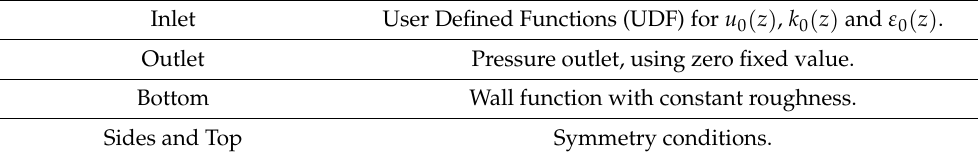
Table 1. Boundary conditions.